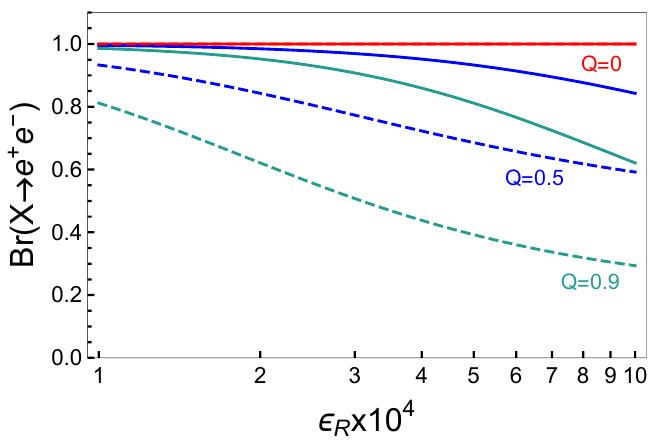
Figure 2 . The branching ratio of X → e + e − as a function of (cid:15) R . Red, blue and green curves correspond to Q = 0 , 0 . 5 and 0 . 9 , respectively. Solid and dashed ones correspond to (cid:15) = 5 × 10 − 4 and 10 − 4